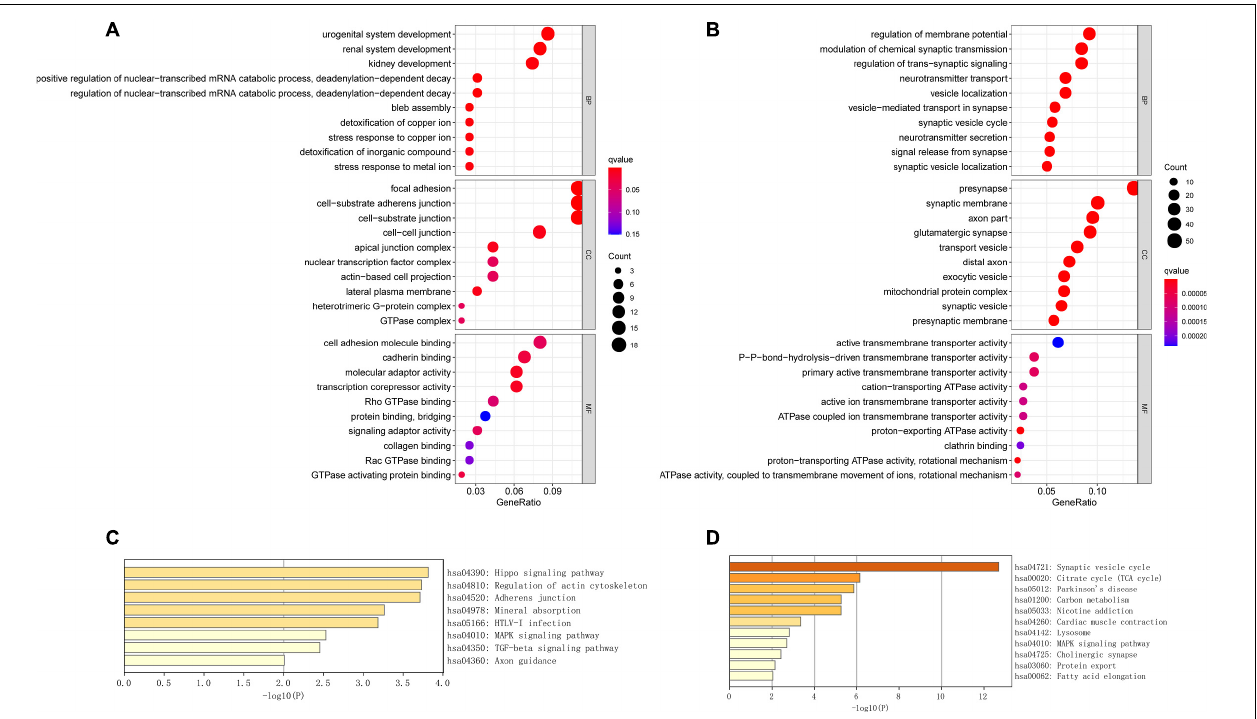
FIGURE 3 | The GO analysis and KEGG pathway analysis of upregulated and downregulated DEGs. (A) The GO analysis of common upregulated DEGs. (B) The GO analysis of common downregulated DEGs. (C) The KEGG pathway analysis of common upregulated DEGs. (D) The KEGG pathway analysis of common downregulated